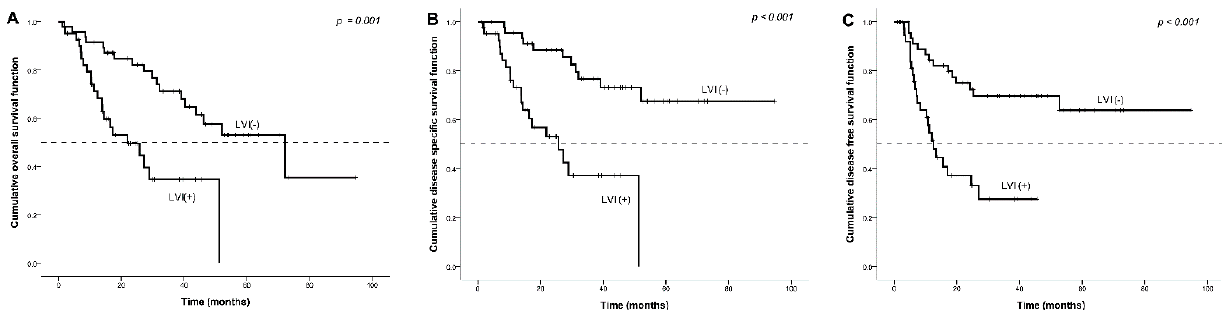
Figure 1. Kaplan–Meier survival curve by the presence of LVI. Impact of lymphovascular invasion (LVI) after salvage total laryngectomy TL on ( A ) overall survival, ( B ) disease-specific survival, and ( C ) disease-free survival.